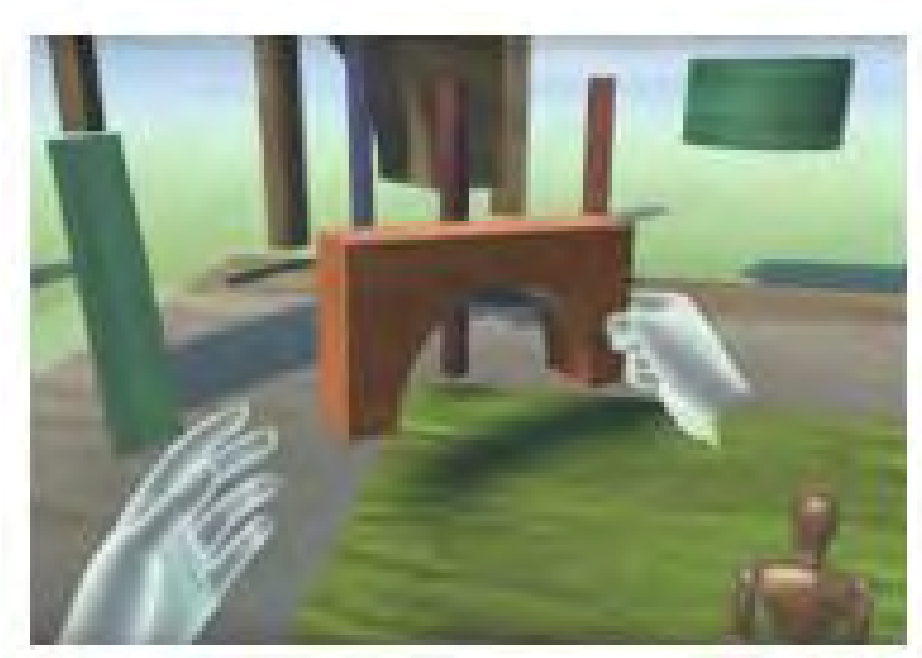
Figure 2. Screenshots of the Kitoparts design tool running on Oculus Rift using Oculus Touch